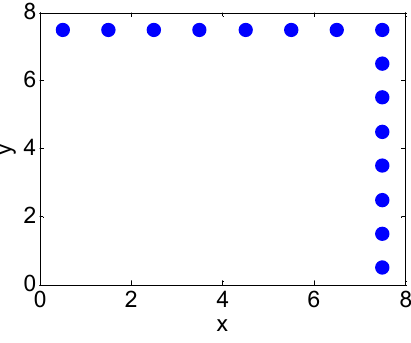
Figure 9. L-shaped array. Figure 9. L-shaped